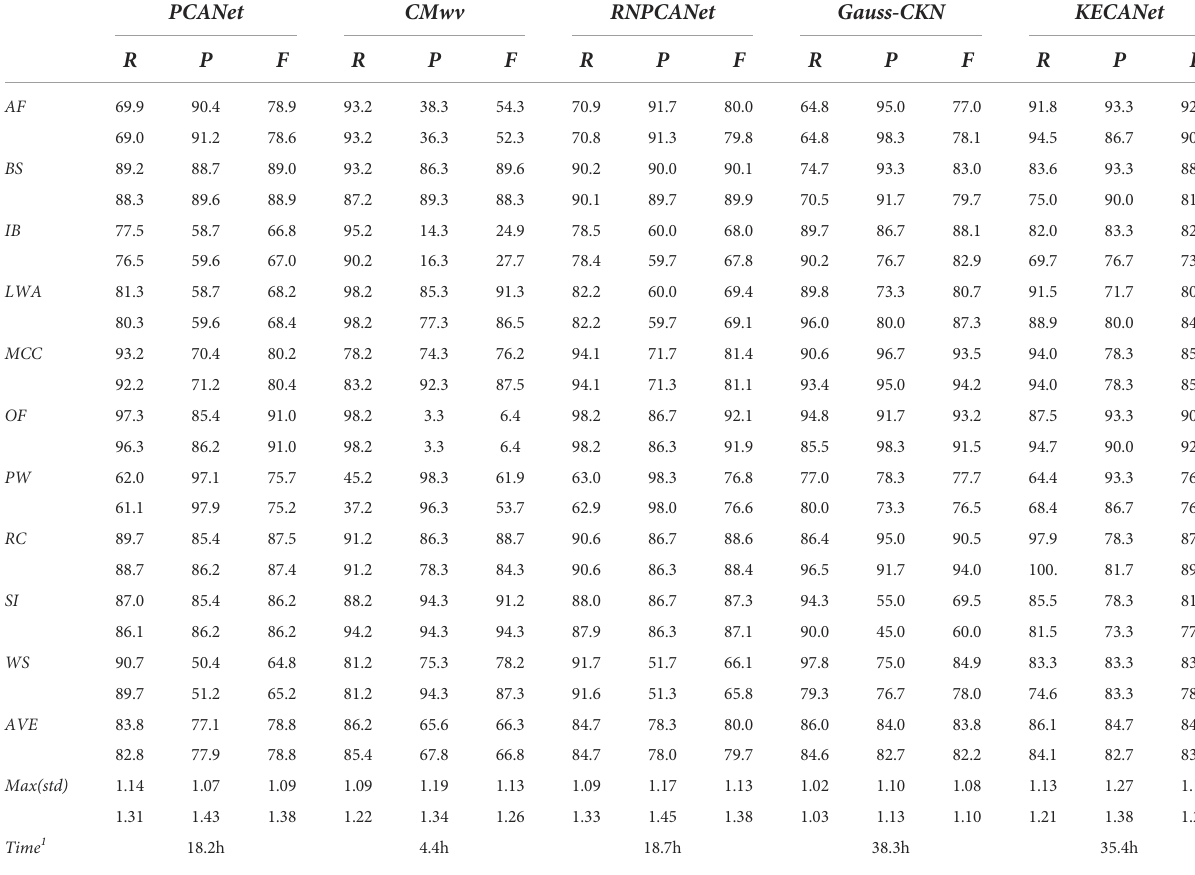
TABLE 6 Classi fi cation performance (%) in WV1 (upper) and WV2 (lower) imagette recognition of different methods. PCANet